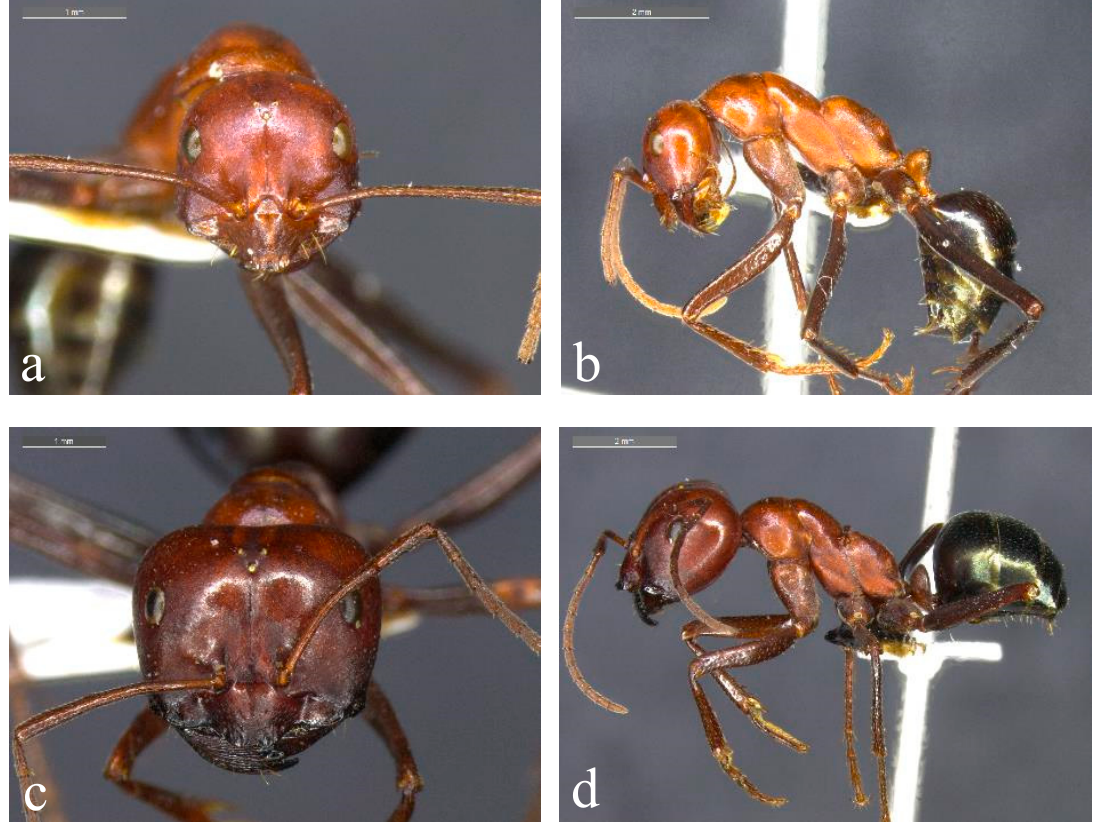
Figure 1. Representative species from the Melophorus rufoniger group. Minor (( a , b ); BOLD ID: MELUS015-19) and major (( c , d ); BOLD ID: MELPS092-18) workers of Taxon 1F, a member of the ‘sp. 1’ complex of the Melophorus rufoniger group from the Gove Peninsula in the NT.